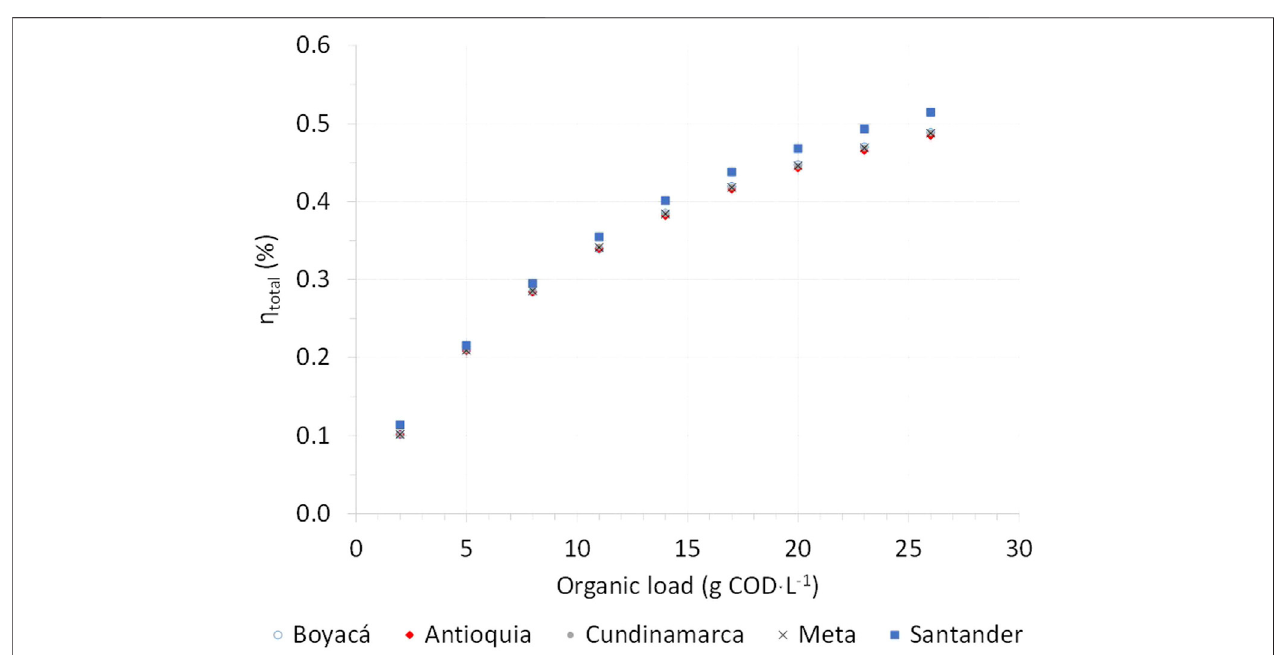
FIGURE4| Totalenergy recoveryyieldasafunctionofinletorganicload:comparative ADFsimulationsaccordingtoCFM, CCM,andSMproduction datain2017.